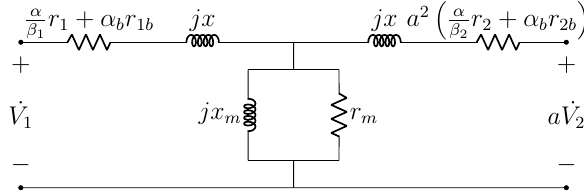
Figure 6. Proposed per phase AC